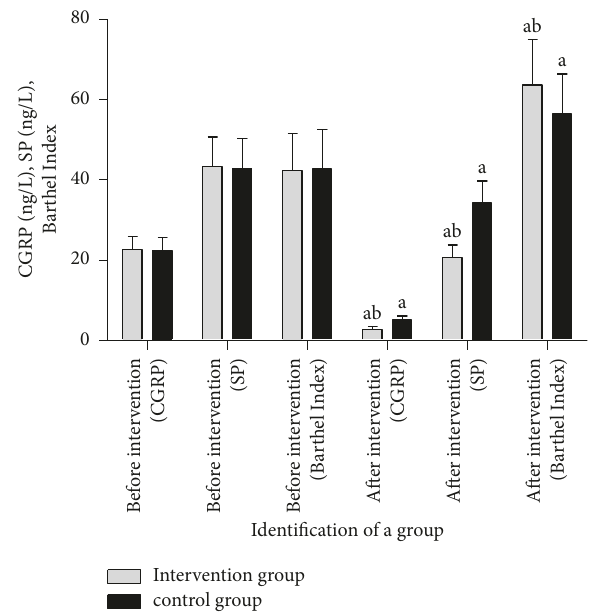
Figure 3: Comparison of CGRP, SP content, and Barthel index between the two groups before and after the intervention (Note: compared with the group before treatment, a P < 0 . 05; compared with the control group, b P < 0 .